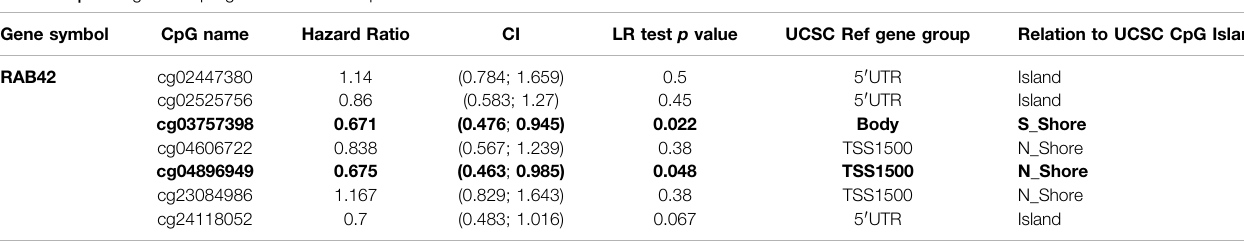
TABLE 3 | The signi fi cant prognostic values of CpG in RAB42. Gene